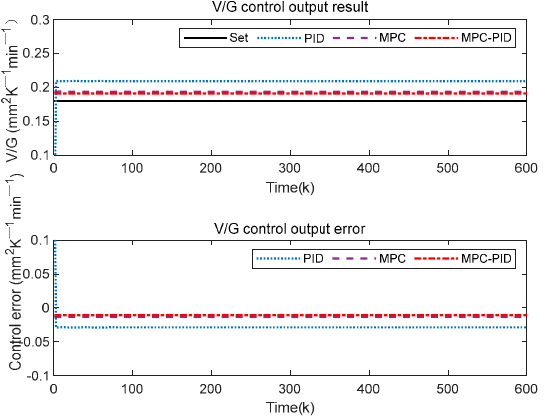
Figure 9. Crystal diameter control output results.